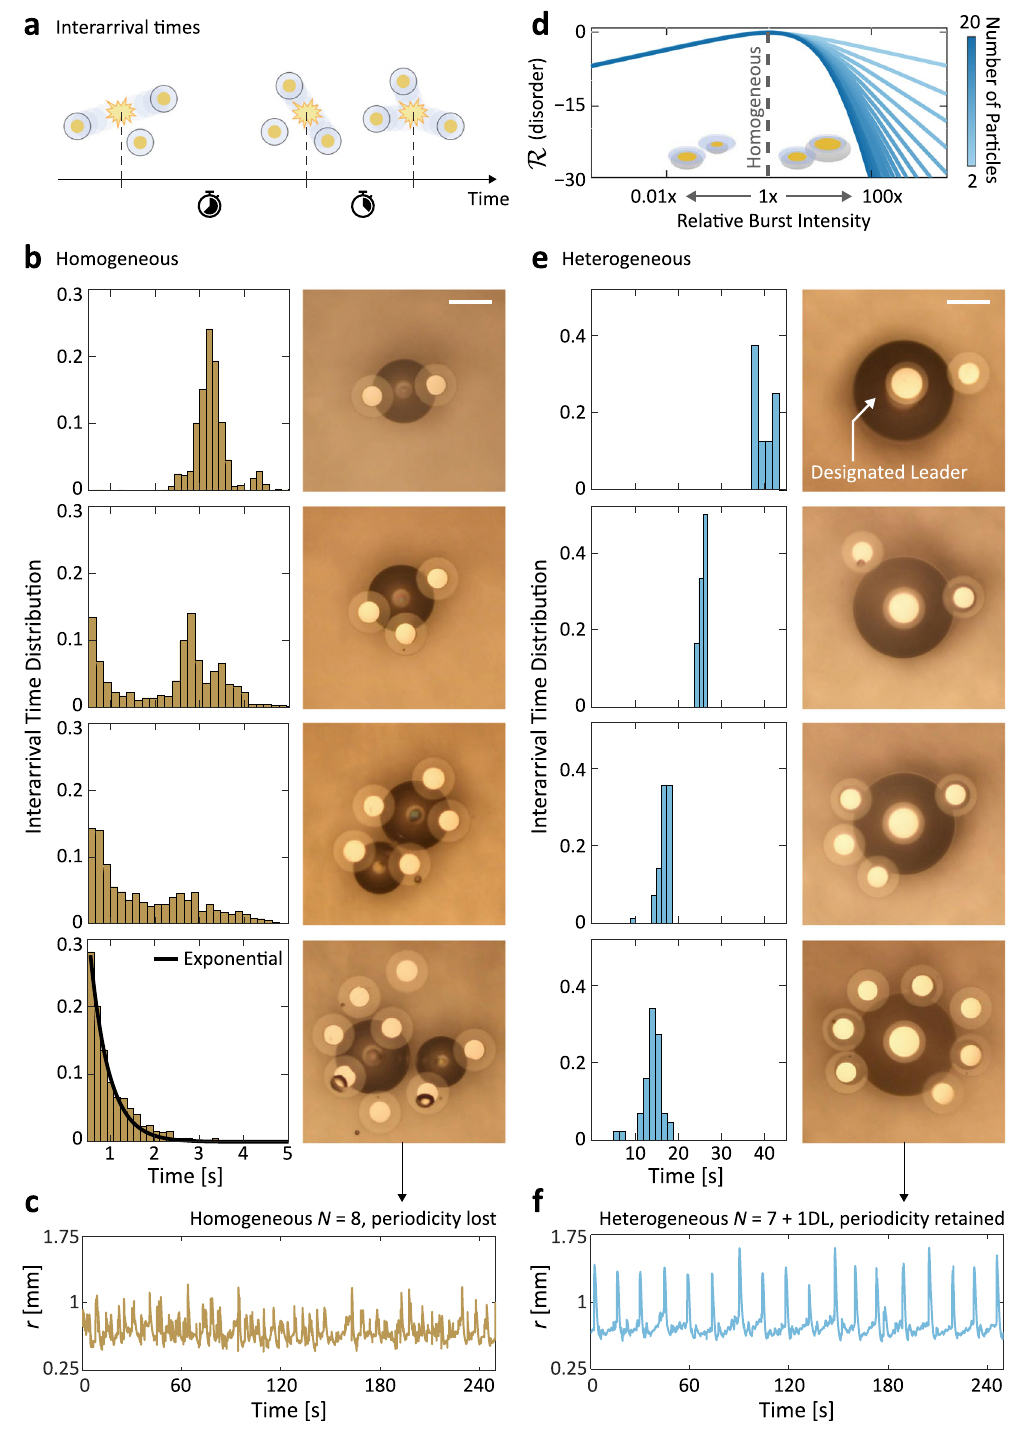
Fig. 2 | Observations of emergent order via symmetry-breaking. a Schematic of interarrival times in a system of beating microparticles, de fi ned as the time that transpires between two consecutive bubblecollapses. The interarrivaltime distribution shouldbetight (i.e., a single peak)ina perfectlyperiodicsystem, and broadin an aperiodicsystem. b (toptobottom)Interarrivaltimedistributionsandopticalmicrographsforhomogeneoussystemsof N =2,3,5,and8identicalparticles.As N increases, thecollectivesystemperiodicitygraduallydecaysandtransitionstoanexponentialinterarrivaldistributionat N =8(bottom,blackcurve).Scalebar,500 μ m. c Indeed,we observe that the breathing radius ofa homogeneous N =8 system is not periodic. d Asymmetry-induced order across N predictedby Rattling Theory. A quanti fi cation of collectivedisorder,thesystem'sRattling R ispredictedtobelower(i.e.moreorderly)iftherelativeburstintensityofoneparticleisincreasedbeyondordecreasedbelow 1x,whichsigni fi eshomogeneity.ThisisexperimentallyrealisedbymodulatingthePtpatchsizeona “ designatedleader ” (DL)particlerelativetotheothers.Thecurvesare offset to make all R =0 at 1x intensity to highlight the effect of system heterogeneity on Rattling. See Supplementary Note 2 for a detailed discussion of the analytical model. e Sameas( b ),butforheterogeneoussystemsofequalparticlenumbers,wheretheDLbrokethepermutationsymmetry.Incontrasttothehomogeneoussystems ( b ), they remain robustly periodic across N . It is important to recognise that the polymeric disc size of a DL is unchanged. Scale bar, 500 μ m. f , Breathing radius for an 8-particle DL system (i.e., N =7+1DL), which reliably beats periodically. The period of 14.2s extracted from r ( t ) coincides with the most probable interarrival time in e (bottom).